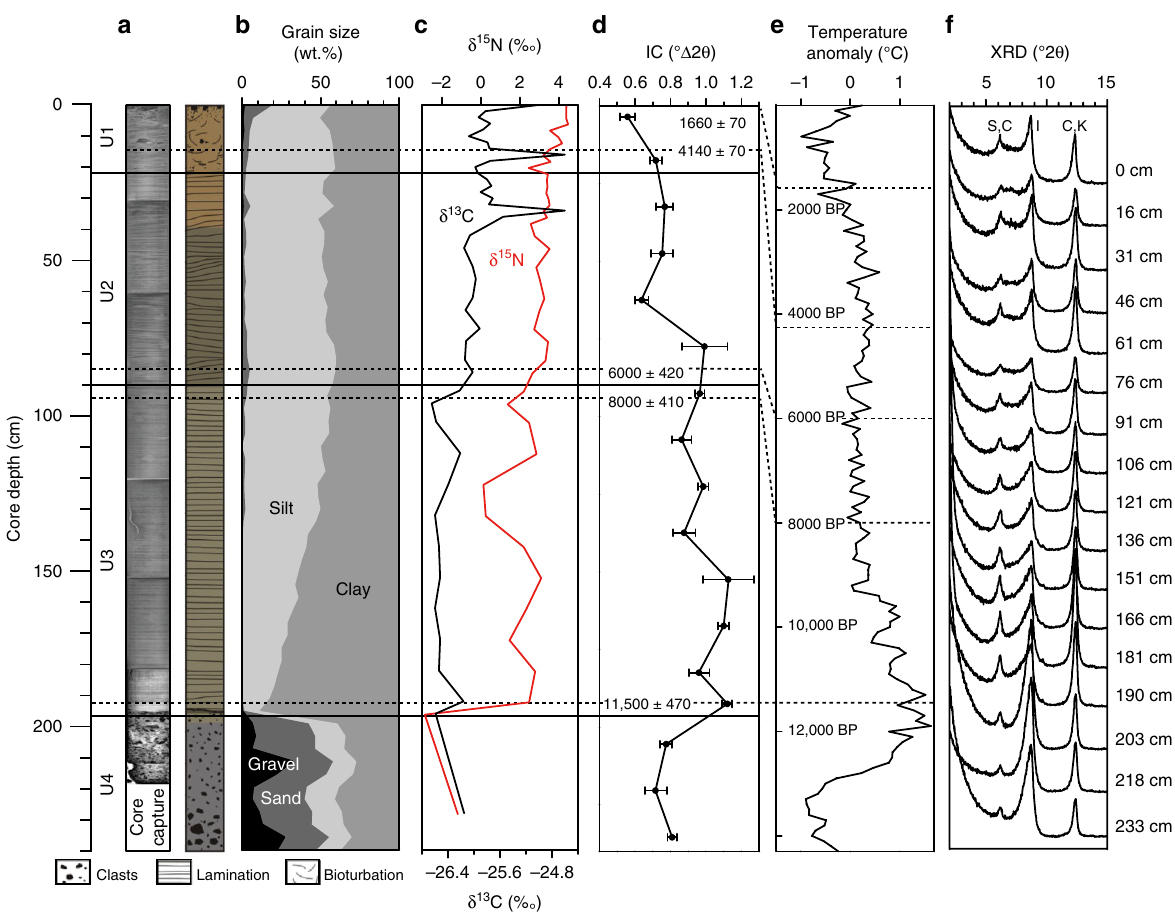
Fig. 2 Downcore variations of EAP13-GC16B. a Sedimentary facies (four distinct lithological units from top (U1) to bottom (U4)) with X-ray core image, b grain-size proportion, c isotopic composition ( δ 13 C and δ 15 N), d iIllite crystallinity (standard deviations were calculated using three independent sets) and calibrated dates, e holocene temperature history of Antarctic Peninsula modi fi ed from Mulvaney et al. 7 , and f X-ray diffractograms of clay minerals (S: smectite; I: illite; C: chlorite; K: